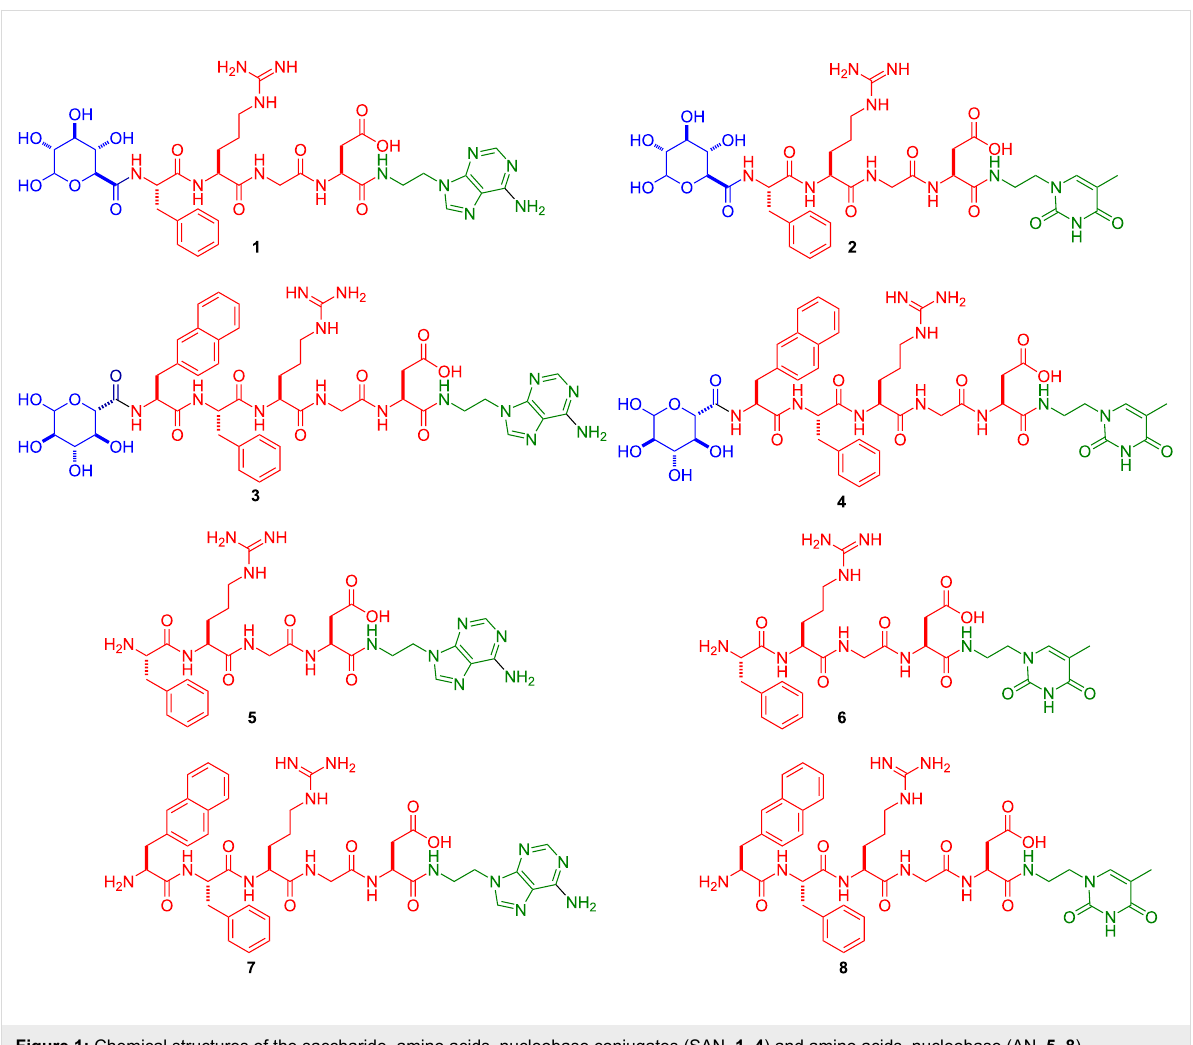
Figure 1: Chemical structures of the saccharide–amino acids–nucleobase conjugates (SAN, 1 – 4 ) and amino acids–nucleobase (AN, 5 – 8